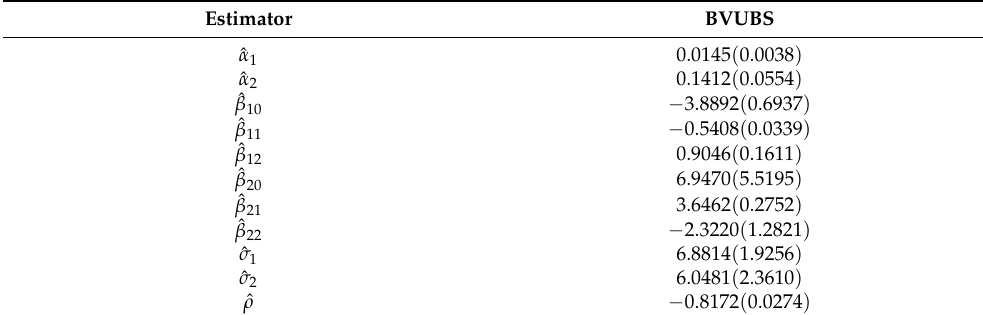
Table 3. Estimation of the parameters with their standard errors for the BVUSHN regression model without outliers.